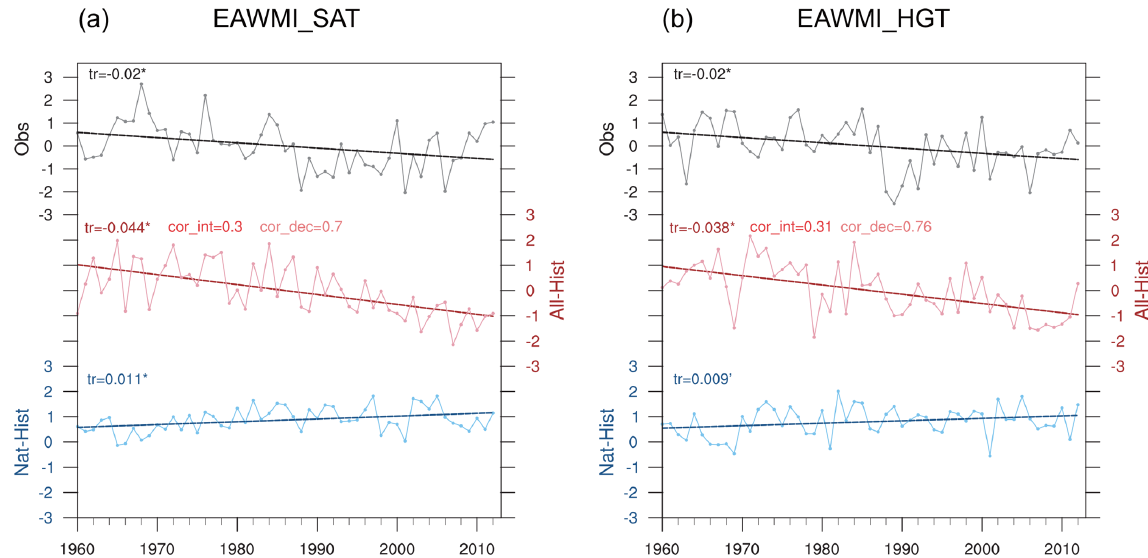
Figure 2. (a) The time series of the normalized EAWMI_SAT (curve) and their linear trend (line) during 1960–2012, based on the NCEP reanalysis dataset (top), outputs of the models in the All-Hist run (middle), and outputs of the models in the Nat-Hist run (bottom). (b) As in (a) but for the EAWMI_HGT. “tr” is an abbreviation for “linear trend coefficient”. “*” means the tr is significant at the 95% confidence level based on the Mann–Kendall test, and “”’ means the tr is significant at the 90% confidence level. “cor” is an abbreviation for “correlation coefficient between the simulated EAWM index under the All-Hist scenario and the observed EAWM index”. “cor_dec” is an abbreviation for “correlation coefficient on a decadal timescale”. Note that the time series of the EAWM indices based on outputs of models in the Nat-Hist runs are standardized by the climatology simulated by the All-Hist